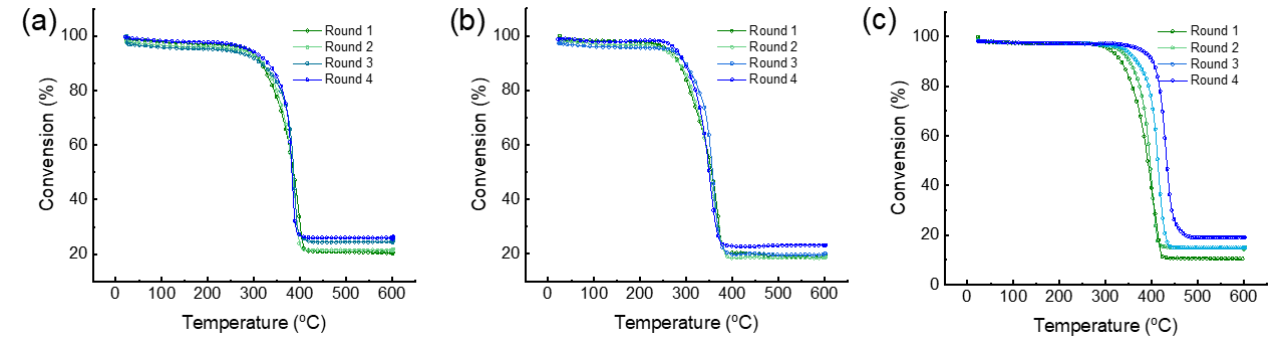
Table 3. Catalytic performance of the different ZSM-5 zeolites for LDPE cracking.